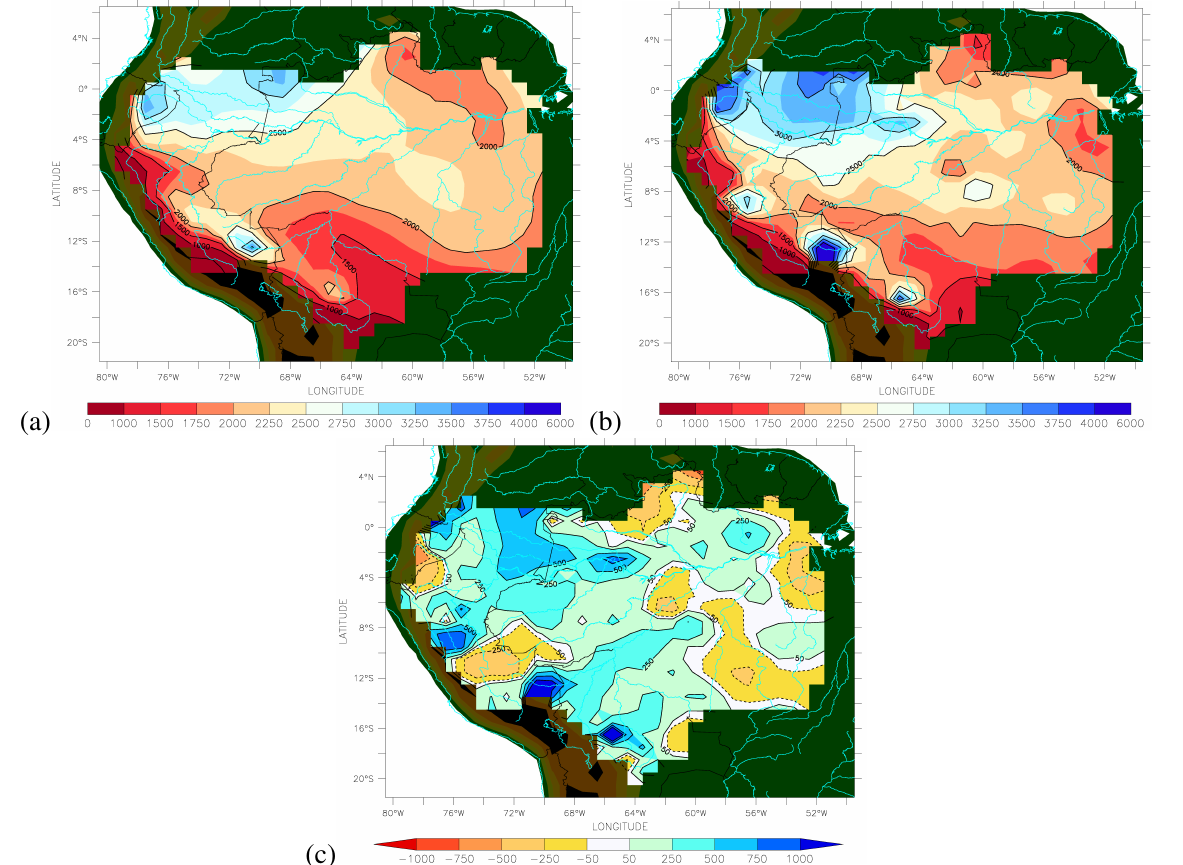
Fig. 3. Precipitation (mmyr − 1 ) over the Amazon River basin from (a) NCC and (b) ORE HYBAM. (c) Differences between (b) and (a) . For topographic scale, see Fig. 2.